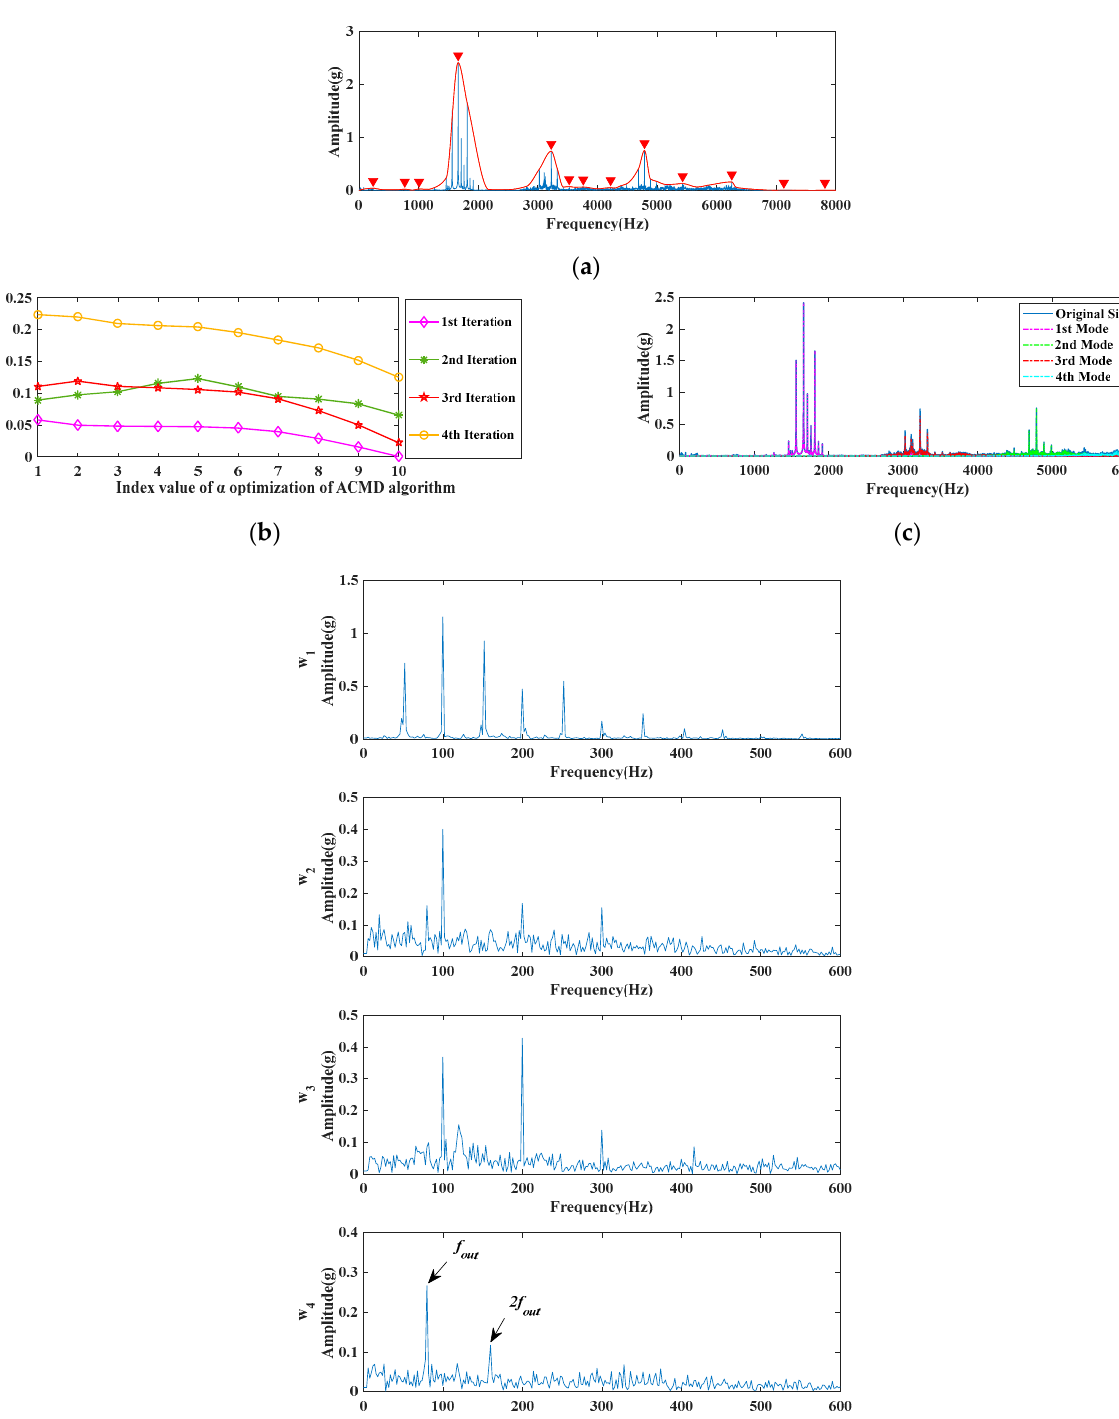
Figure 25. Proposed diagnostic strategy analysis results of engineering fault signal: ( a ) envelope and interpolation results; ( b ) ELK values with different α at each F in ; ( c ) spectrum distribution results of the obtained modes; ( d ) envelope spectrums of the obtained modes.